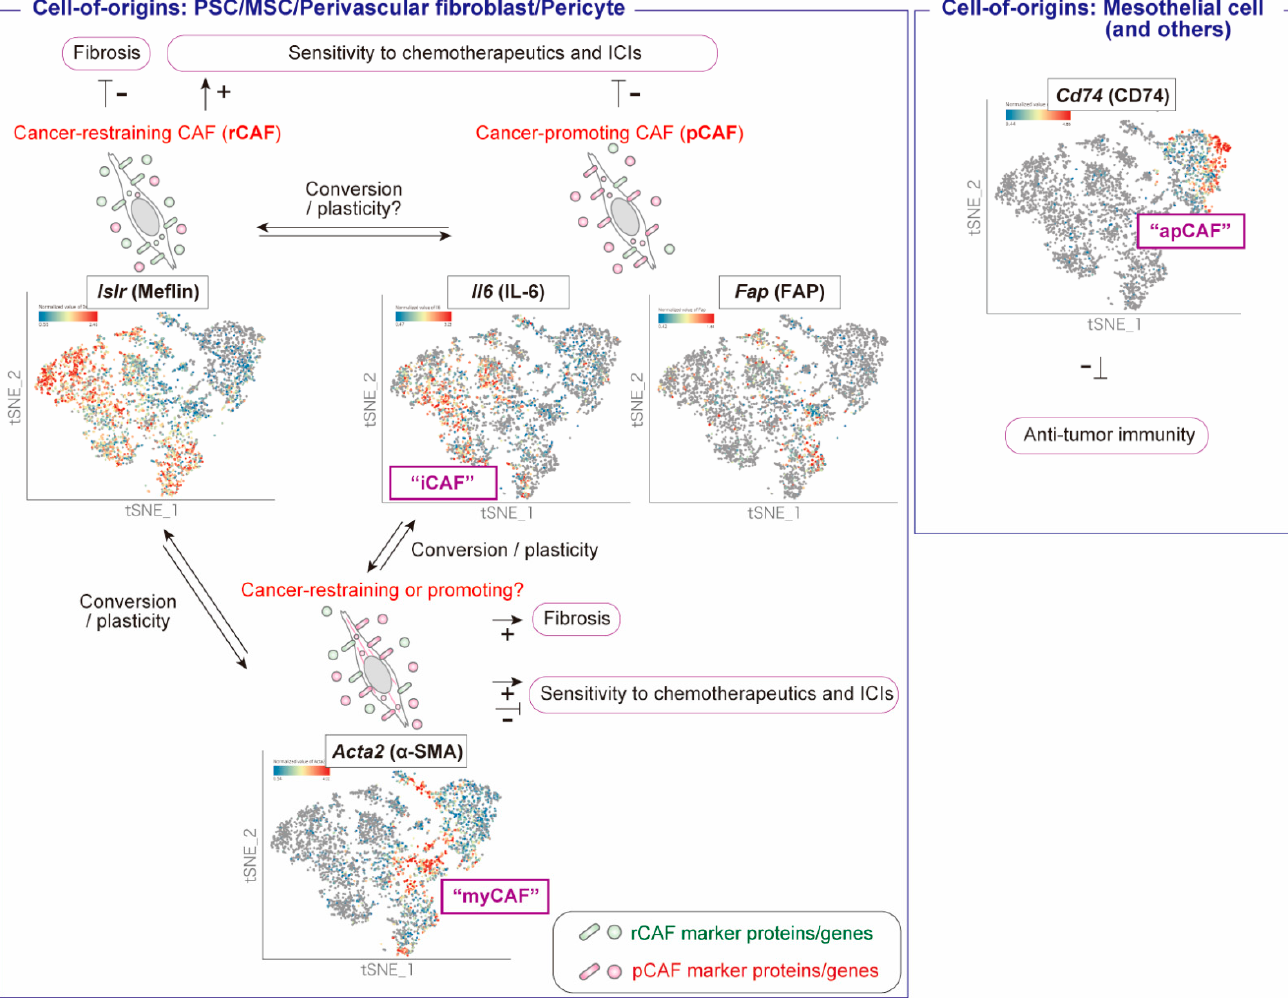
Figure 2. Current classification of CAFs in PDAC. The expression of the indicated CAF marker genes ( Islr , Il6 , Fap , Acta2 , and Cd74 ) in CAFs isolated from tumors of the KPC mouse model of PDAC was visualized using t-distributed stochastic neighbor embedding (t-SNE) plots. Publicly available single-cell RNA sequence data of all fibroblasts isolated from four KPC mouse with PDAC tumors (GEO accession code: GSE129455, Elyada et al. [24]) were analyzed and visualized using the Bioturing Bbrowser. It should be noted that different CAF marker genes were expressed in different CAFs at varying degrees of overlap. Recent studies have shown that Meflin protein encoded by the Islr gene possesses cancer-suppressing roles; however, the precise roles of Meflin + CAFs have not been demonstrated clearly. α -SMA + myCAFs play a role in suppressing the progression of pancreatic cancer in mice; however, the functions of α -SMA protein and other proteins expressed in myCAFs have not yet been demonstrated. apCAFs are derived from mesothelial cells and have a different origin from other types of